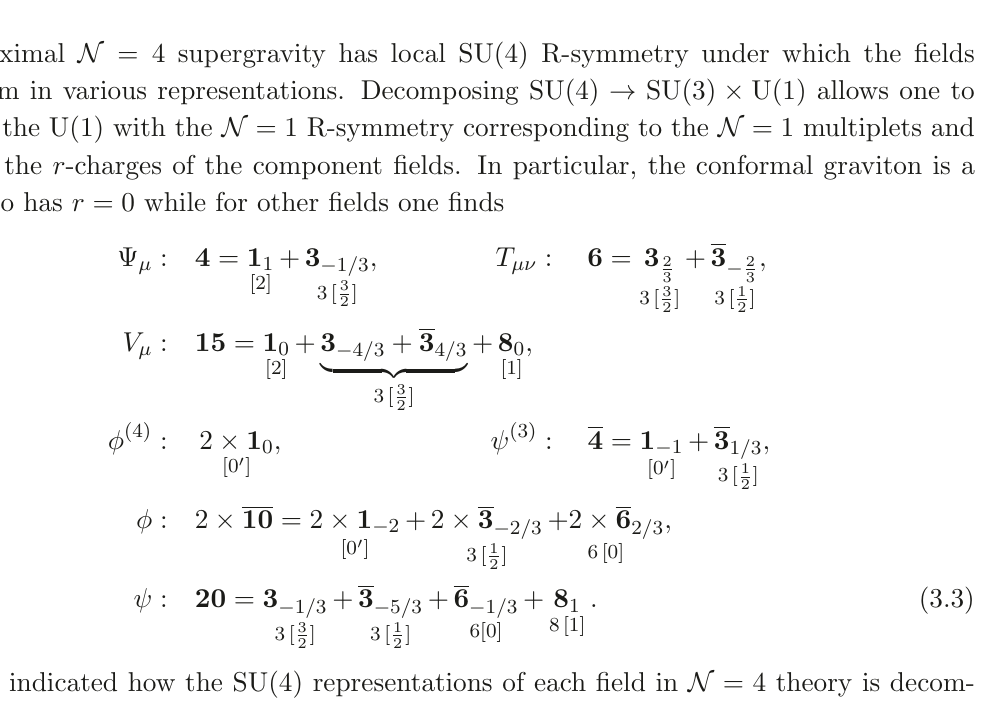
Table 1 . Conformal anomaly coefficients of fields appearing in